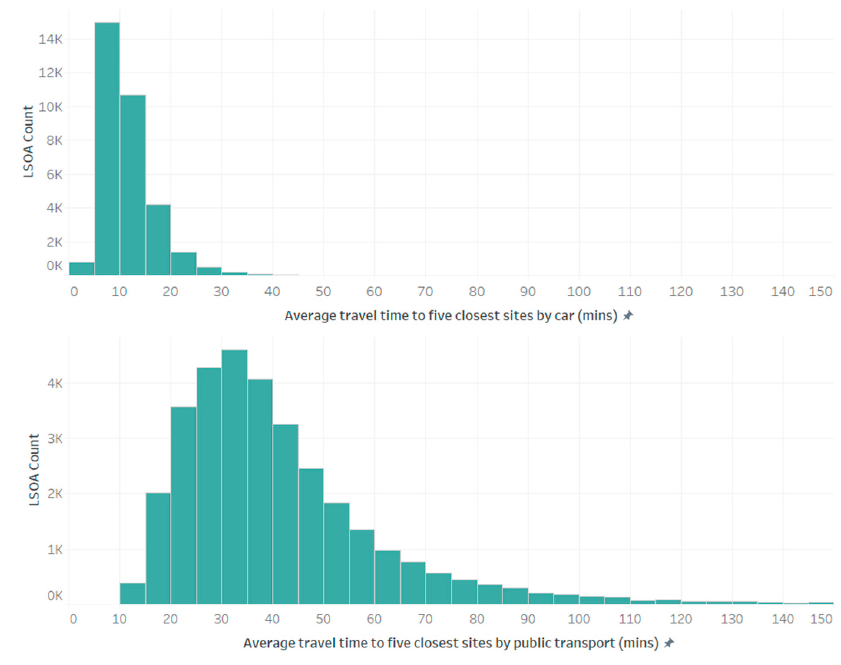
Figure 2. Histograms comparing average journey times to closest five vaccination sites by private car and public transport on an LSOA by LSOA basis.